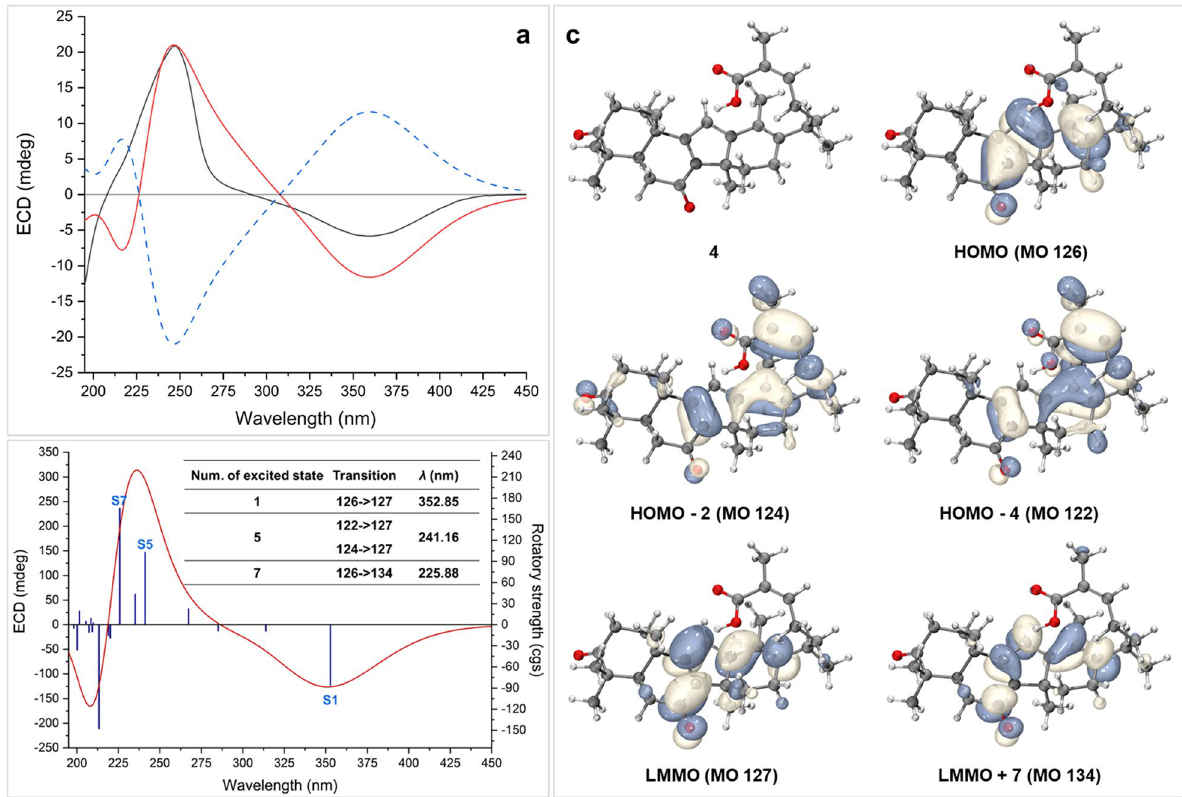
Fig. 6 a Experimental ECD spectrum of 4 (black). Calculated ECD spectra (shift Calculated ECD spectrum (curve) of conformer 4a-1 with rotatory strength (bar), and the key transitions in three important excited states (table). c Key MOs of conformer 4a-1